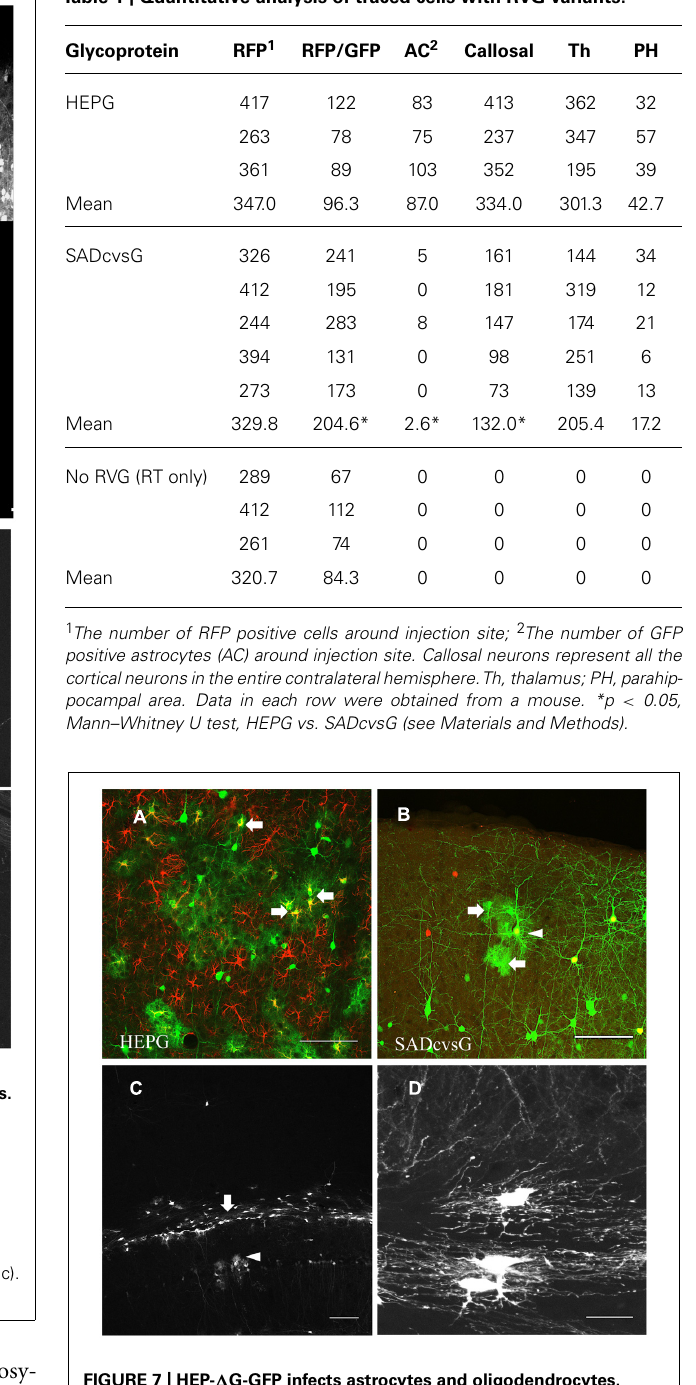
FIGURE 7 | HEP- Δ G-GFP infects astrocytes and oligodendrocytes. (A) Astrocytes (arrows) visualized by rabies monosynaptic tracing with HEPG. A brain slice containing GFP cells (green) was immunostained with antibody against GFAP (red). (B) Occasional infection of astrocytes (arrows) around a presumed starter neuron (arrowhead) in rabies monosynaptic tracing with SADcvsG. (C) Infection by SADcvsG-HEP- Δ G-GFP of oligodendrocytes (arrow) in the white matter and astrocytes in the hippocampus (arrowhead) by direct viral injection. (D) Fine structure of oligodendrocytes in the white matter. Scale bars = 100 μ m (A–C) and 20 μ m (D)